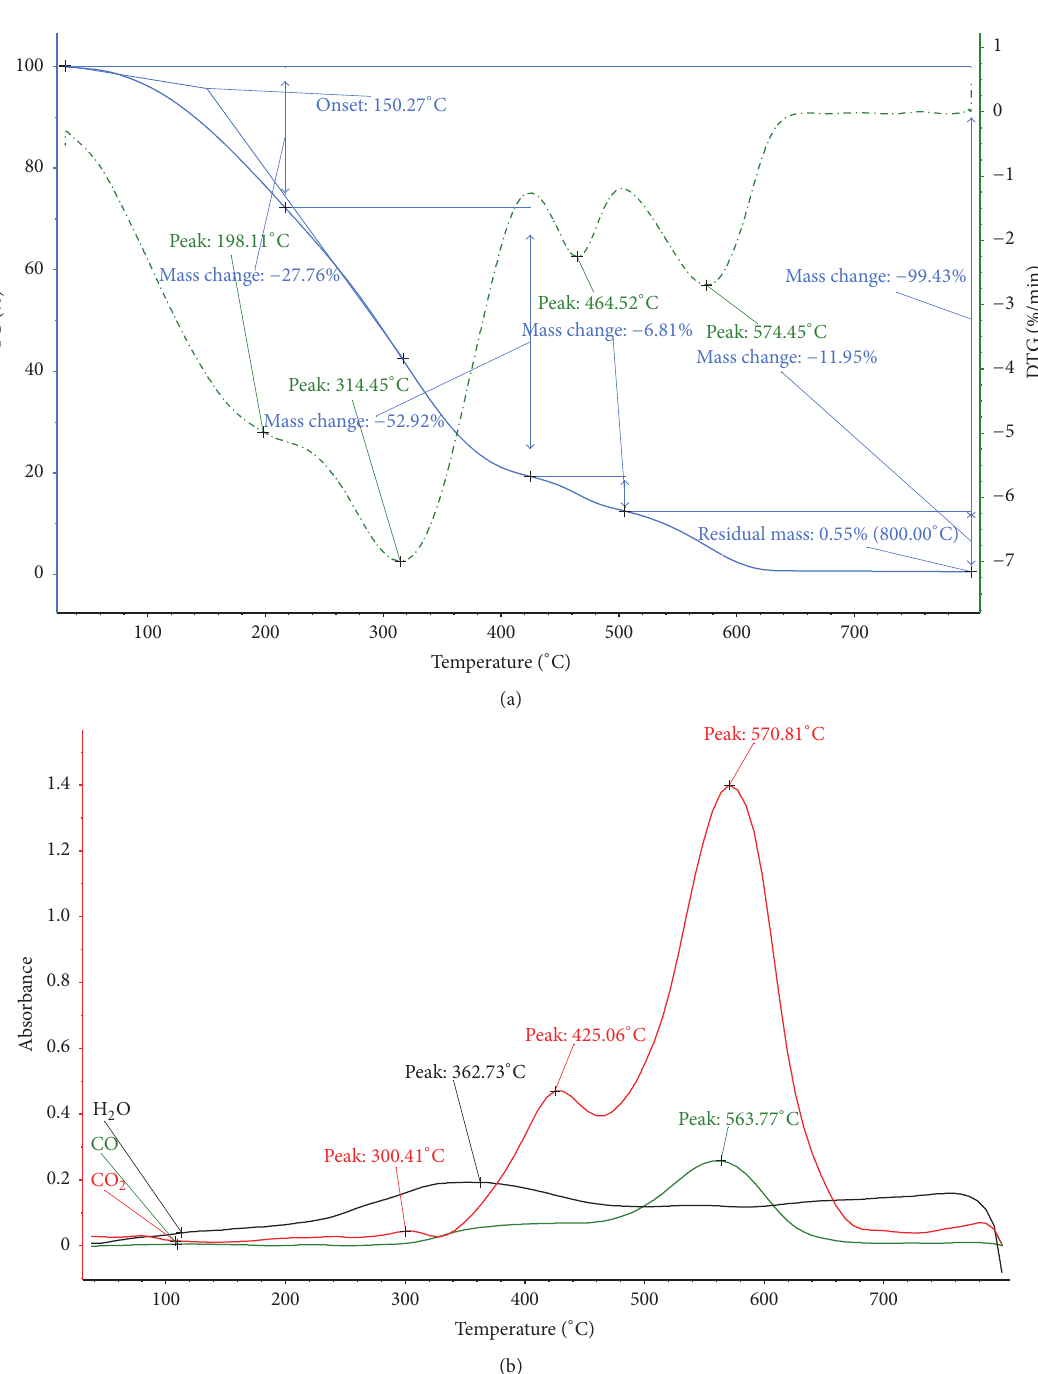
fractions in crude oil; these fractions have polar groups in their composition and are able to form stable